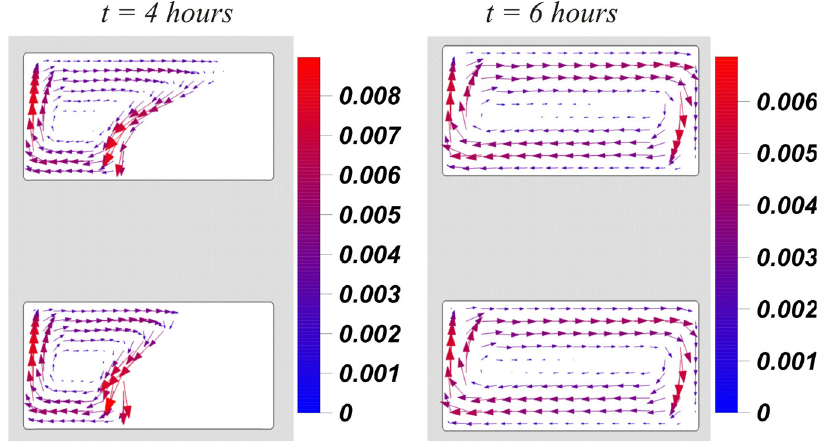
Figure 7. Dimensionless velocity field at times t = 4 h and t = 6 h for the case of L = 0.01 m and ∆ T = 20°.